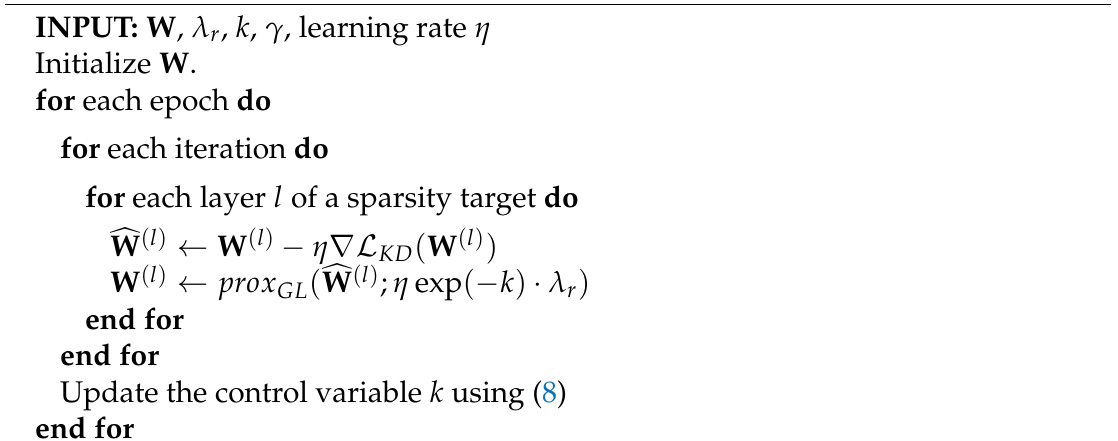
Algorithm 1 Optimization with a closed-loop feedback